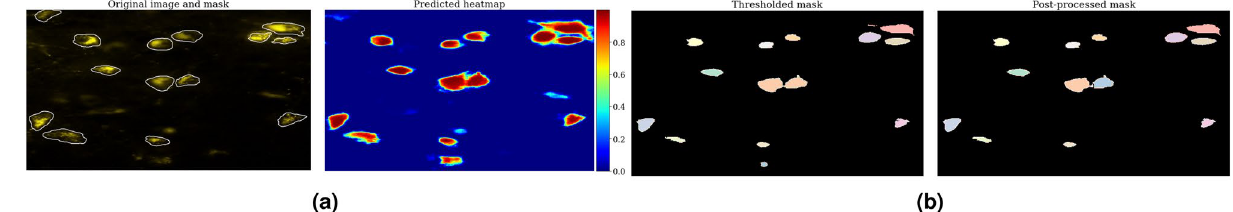
Figure 4. Model output. From left to right, the input image with white contours indicating annotated cells; the model’s raw output (heatmap); the predicted mask after thresholding at 0.875; the predicted mask after post-